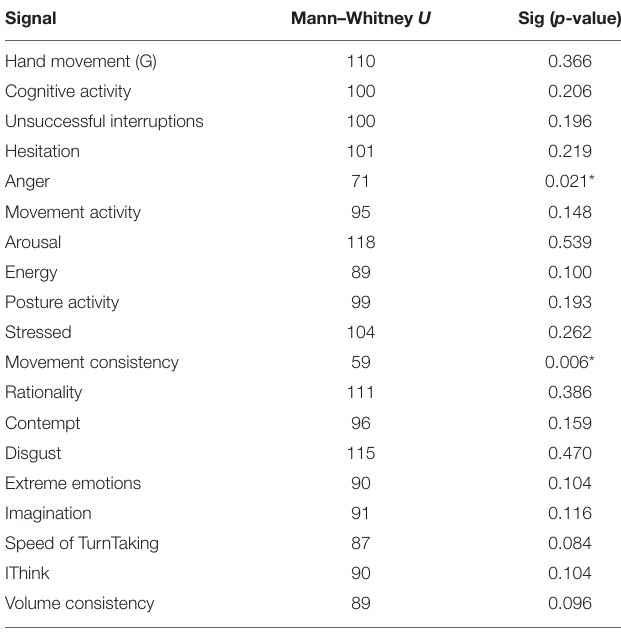
TABLE 5 | Man–Whitney U test